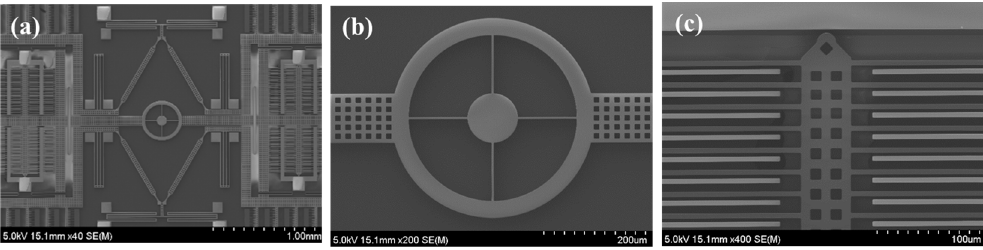
Figure 5. SEM images of a fabricated tuning fork gyroscope: ( a ) TFG chip, ( b ) close-up of the self-rotation ring, and ( c ) sensing comb electrodes.